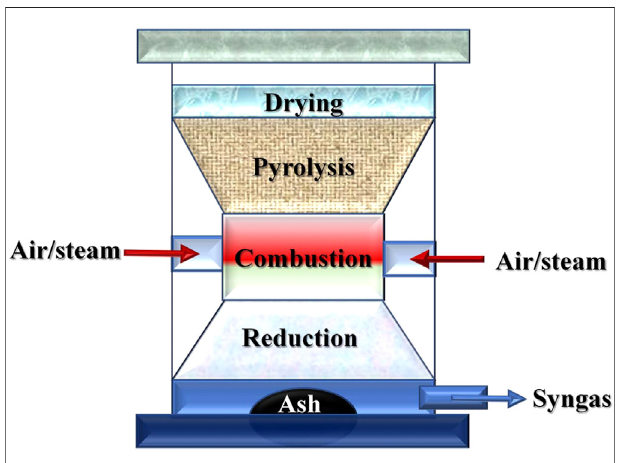
FIGURE 1 | A schematic of downdraft gasi fi